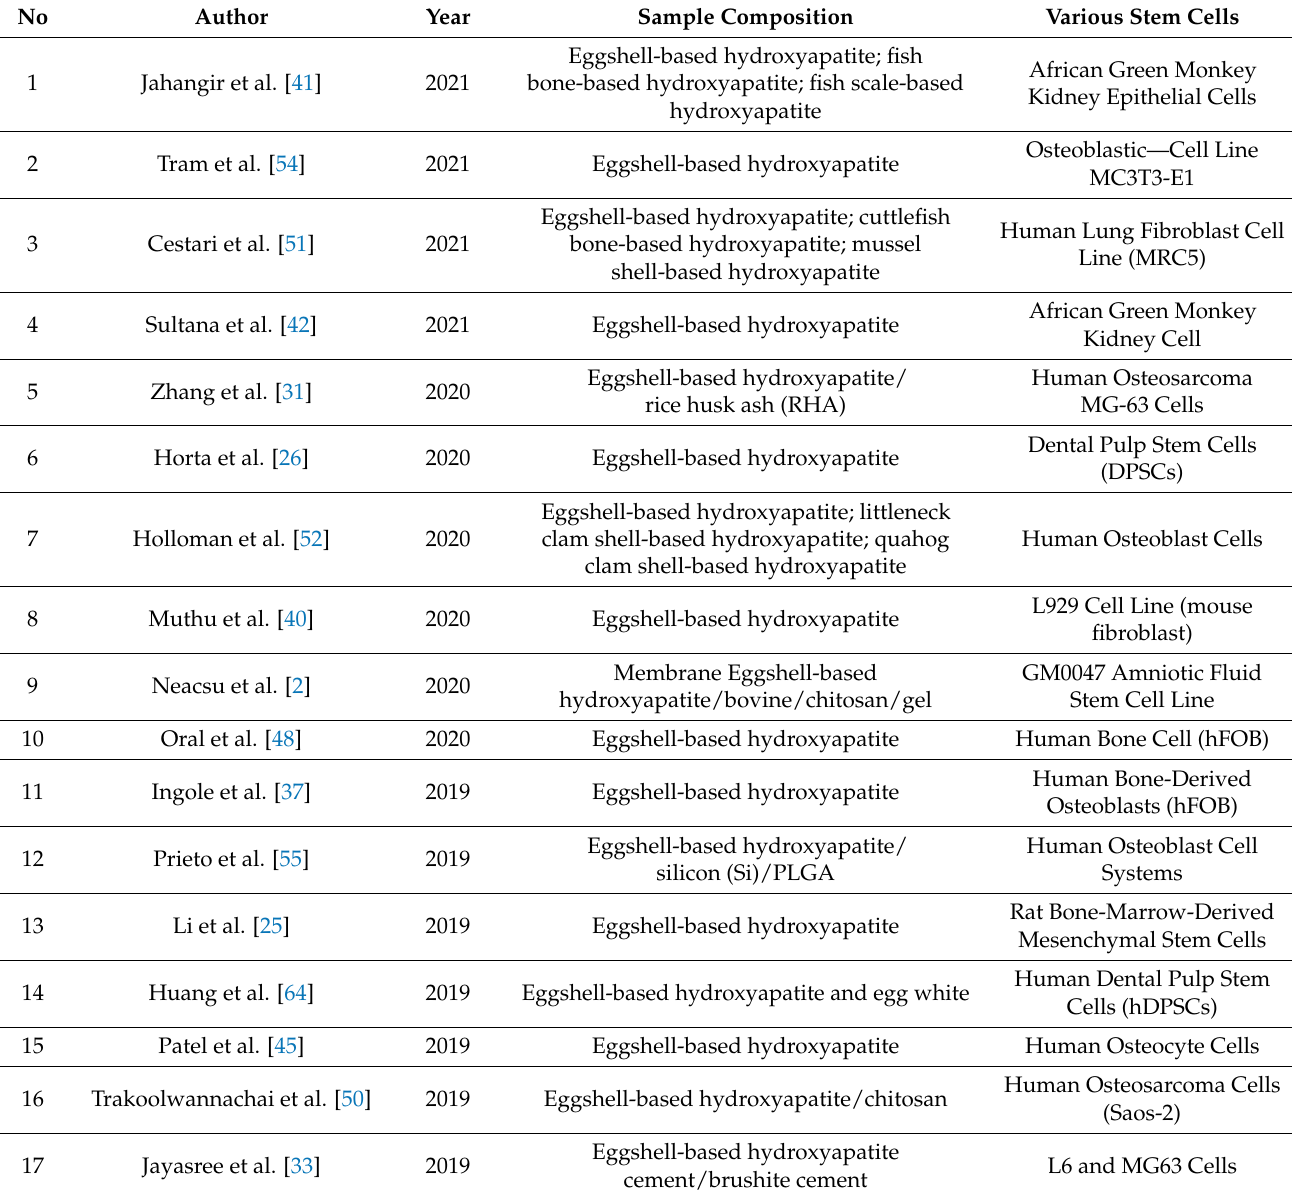
Table 2. In vitro cytotoxicity test data based on various stem cells used for the